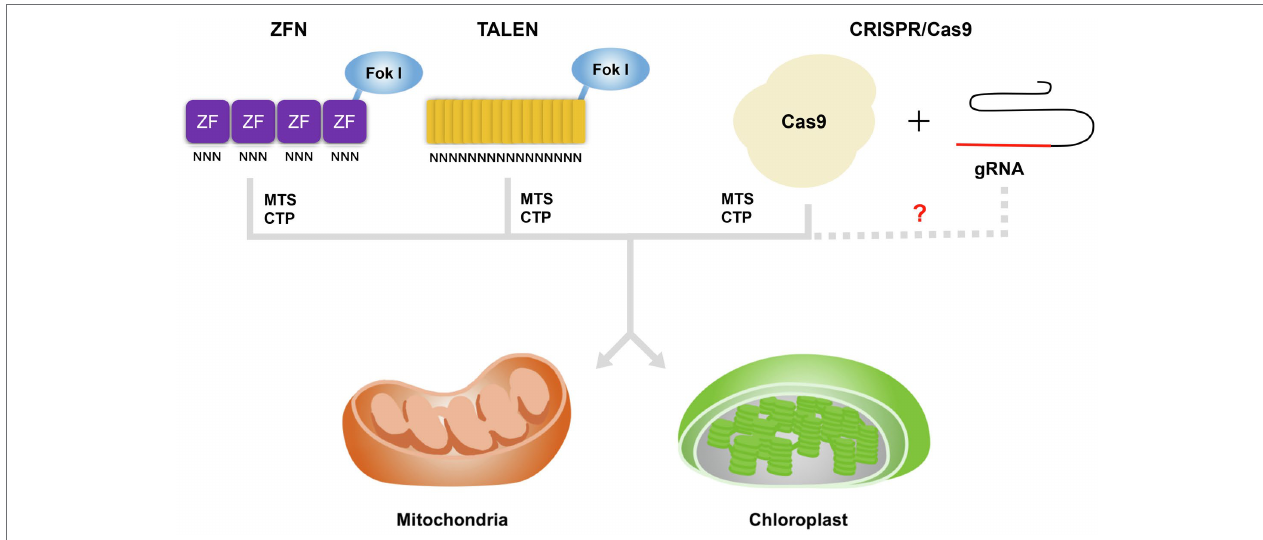
FIGURE 1 | Strategies to import genome editing reagents into mitochondria or chloroplasts in plant cells. Adding a targeting peptide such as a mitochondrial targeting sequence (MTS) or chloroplast transit peptide (CTP) to zinc-finger nucleases (ZFNs), transcription activator-like effector nucleases (TALENs), and clustered regularly interspaced short palindromic repeats-associated nuclease 9 (Cas9) allows their translocation into mitochondria or chloroplasts. In human HEK293K cells, the addition of an RNA transport-derived stem loop element to the sgRNA resulted in its mitochondrial import (Hussain et al., 2021). However, equivalent RNA sequences that might target sgRNAs to mitochondria or chloroplasts are currently unknown in